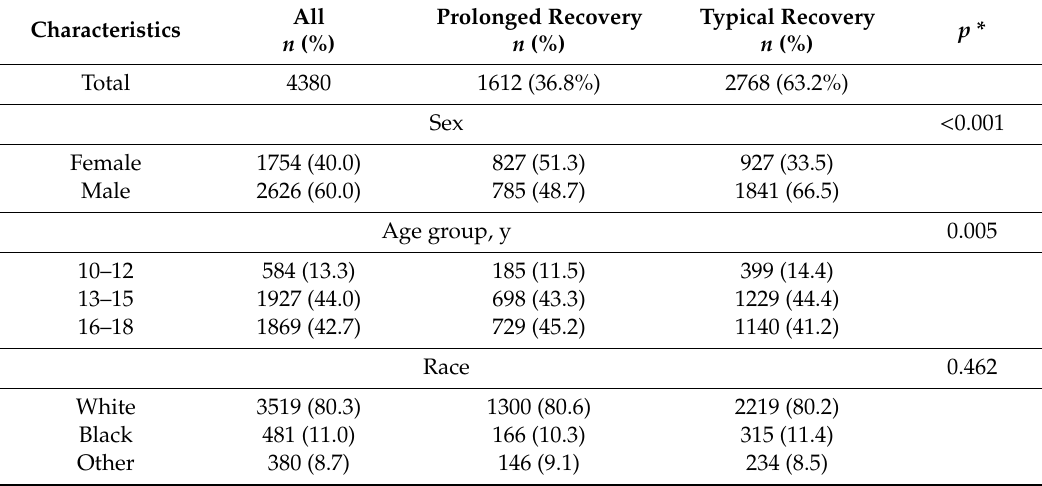
Table 2. Patient and Injury Characteristics by Prolonged and Typical Recovery Groups.